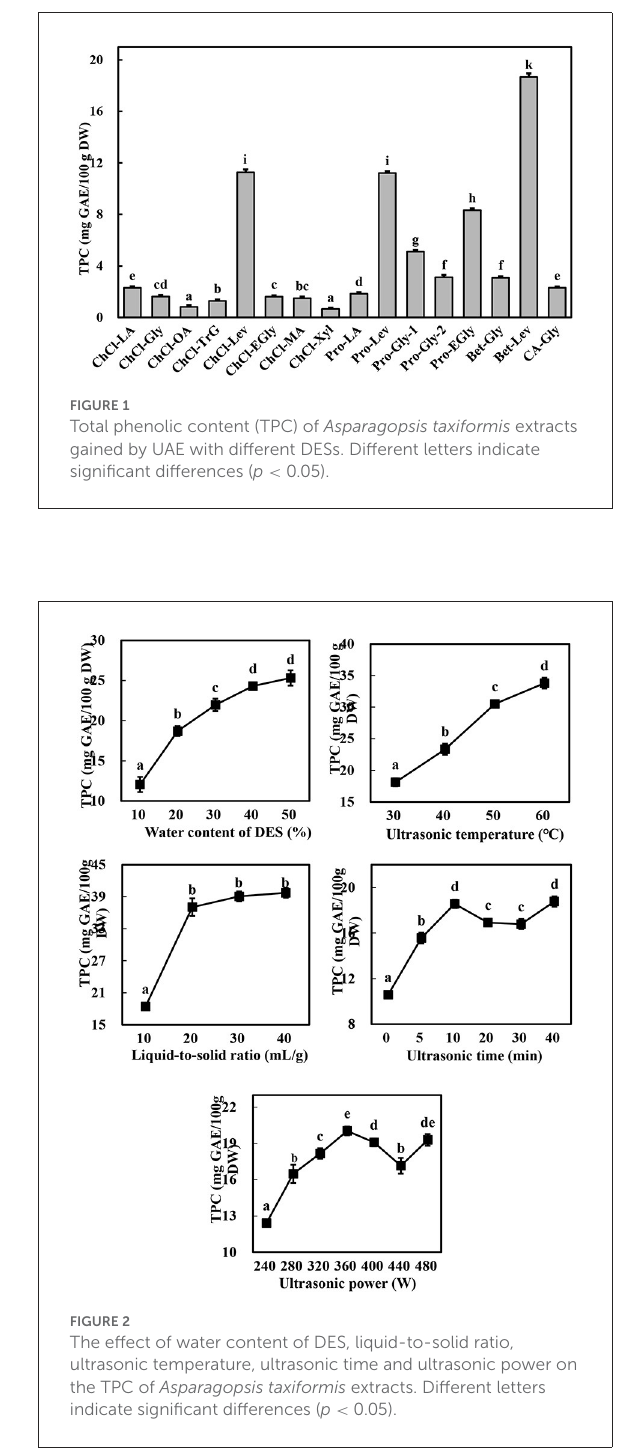
together with its highly similar polarity to that of the phenolics in A. taxiformis. Therefore, we selected Bet-Lev as the DES for the subsequent